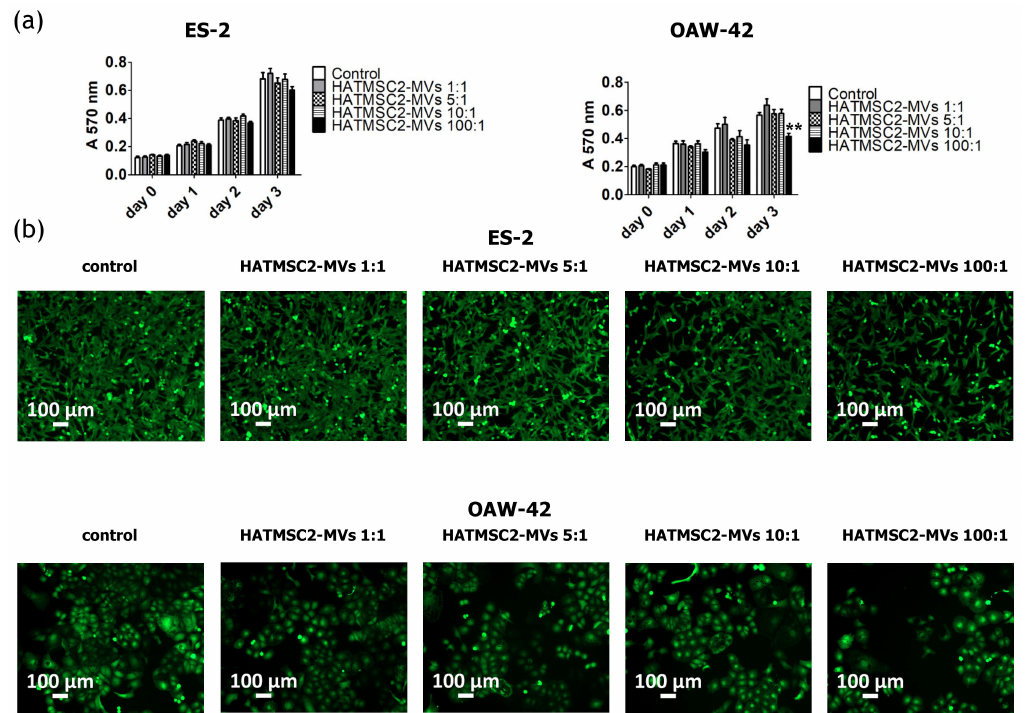
Figure 4. E ff ect of HATMSC2-MVs on the proliferation activity of ovarian cancer cells. ( a ) Proliferation activity of ES-2 and OAW-42 cells cultured in standard conditions was measured using an MTT assay on day 0, 1, 2, and 3 following treatment with HATMSC2-MVs at di ff erent ratios. Untreated cells without MVs served as a control. The data represent mean ± SEM values from four independent experiments performed in triplicate. ** p < 0.01 calculated vs. control on a given day. ( b ) Representative images from microscopic analysis of the morphology of ovarian cancer cells treated with HATMSC2-MVs at di ff erent ratios. ES-2 and OAW-42 cells were co-incubated with HATMSC2-MVs for 72 h. Afterwards, the cells were stained with Calcein AM and images were taken using an inverted microscope (scale bar: 100 µ m). HATMSC2-MVs—microvesicles derived from immortalized human mesenchymal stem cells of adipose tissue